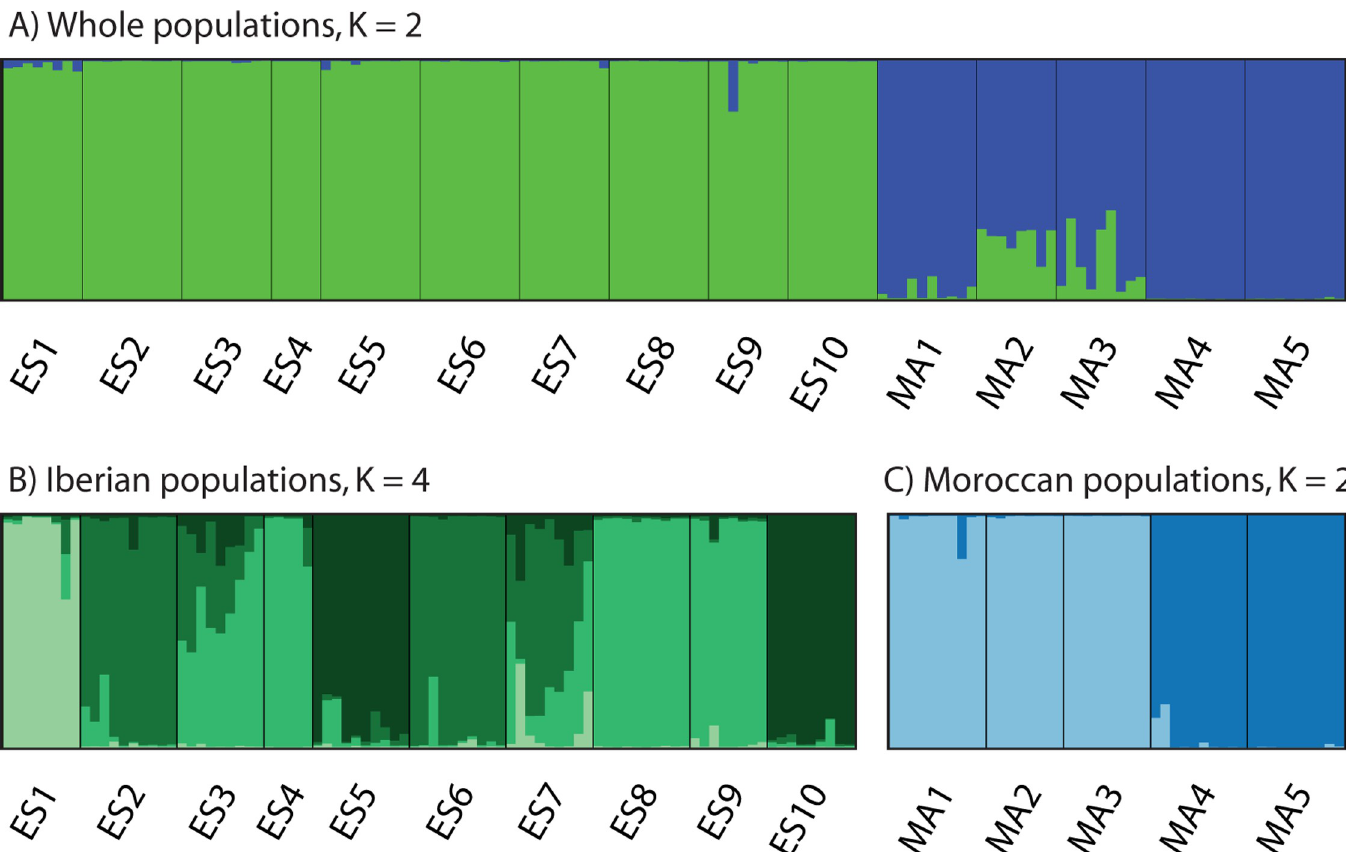
Fig 3. The most optimal K results using Bayesian clustering analyses with Structure based on AFLP results. (A) Using whole populations of Cynara baetica ( K = 2). (B) Using only Iberian populations of C . baetica ( K = 4). (C) Using only Moroccan populations of C . baetica ( K = 2).